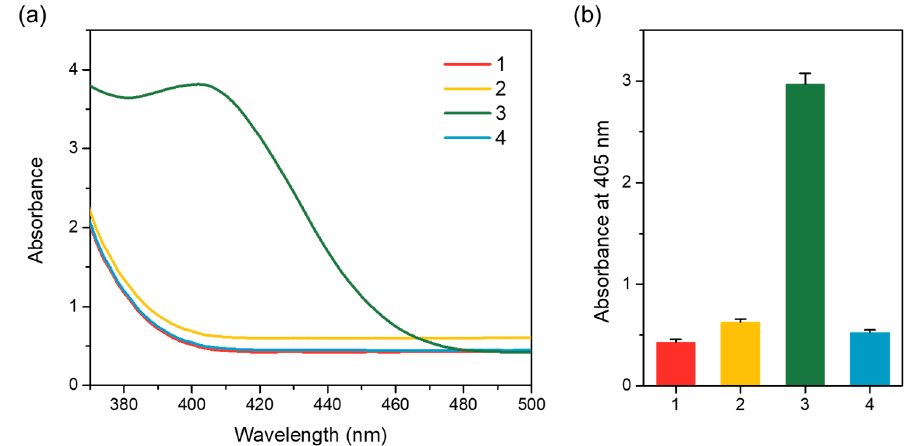
Figure 2. Characterization of antibody immobilization of CPs based on colorimetric method utilizing p -NPP substrate. Absorbance spectra ( a ) and absorbance intensity at 405 nm ( b ) of (1) bare magnetic particles (MNPs), (2) CPs, (3) CPs with anti-goat IgG Ab-ALP, and (4) CPs with secondary antibody (mouse anti-human IgE Ab-ALP).